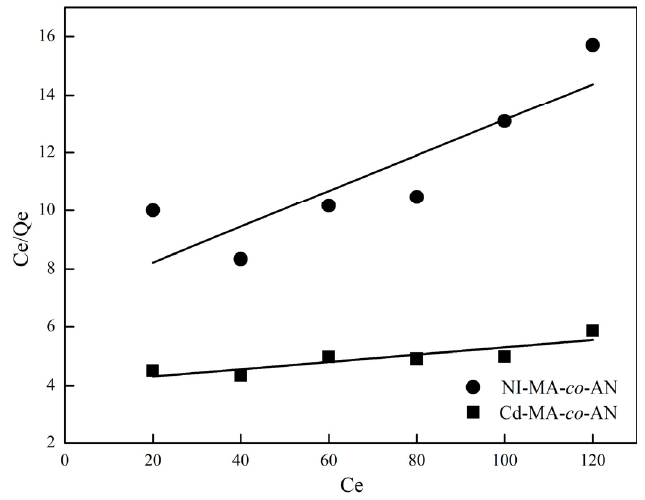
Figure 8. Langmuir isotherm model. Table 1. Langmuir isotherm constants for adsorption of Cd-I-MA- co -AN and NI-MA- co -AN. Adsorbent